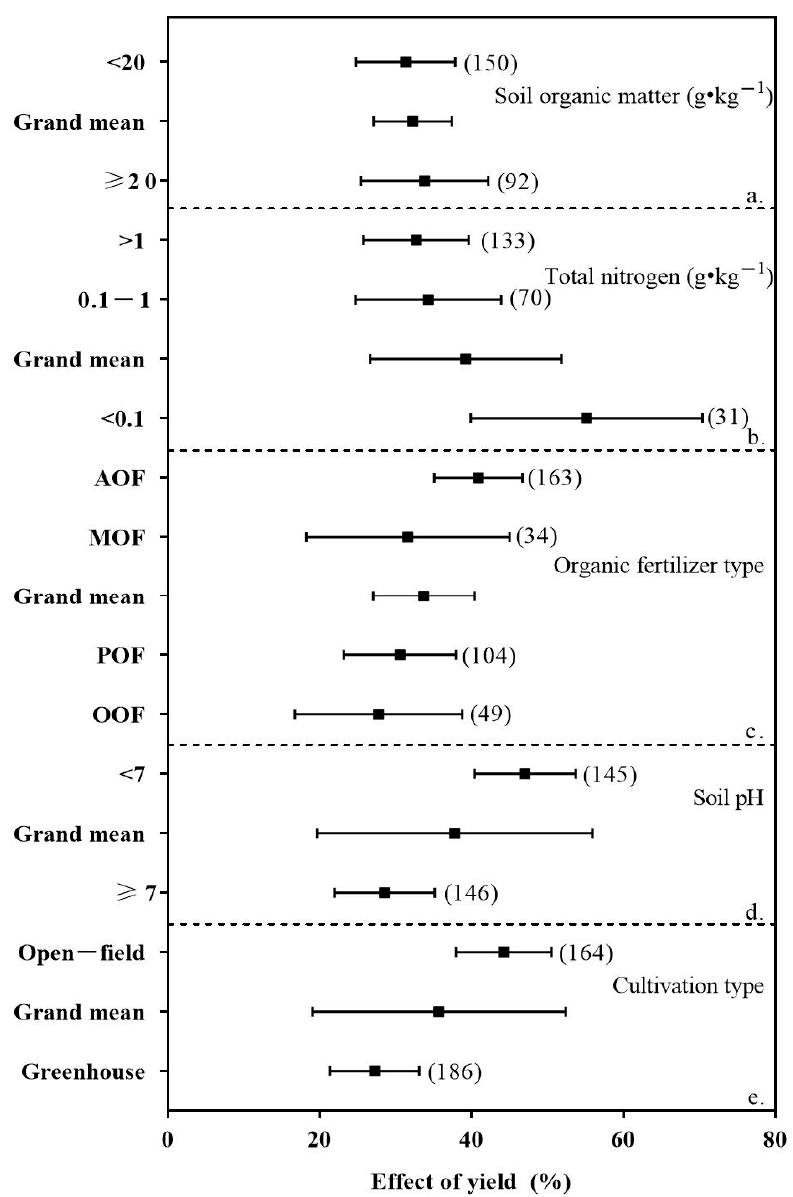
Figure 4. Organic fertilizers combined with soil organic matter ( a ), total soil nitrogen ( b ), type of organic fertilizers ( c ), soil pH ( d ), and cultivation type ( e ) on tomato yield percentage changes. Points represent the mean effect, while bars represent 95% confidence intervals. The numbers on the right side of the confidence intervals represent the sample sizes. AOF, animal organic fertilizer; MOF, mixed animal-and-plant organic fertilizer; POF, plant organic fertilizer; OOF, other organic fertilizer. The percentage change of organic fertilizers on the soluble sugar of tomato increased significantly when the organic matter was <20 g · kg − 1 ; the percentage change of organic fertilizers on the soluble sugar of tomato increased by 60.35% (Figure 6a). The percentage change was − 18.09% when the organic fertilizers were ≥ 20 g · kg − 1 . When the total soil nitrogen was 0.1–1 g · kg − 1 and >1 g · kg − 1 , organic fertilizers had positive effects on tomato soluble sugar, and the percentage changes were 51.86% and 30.53%, respectively (Figure 6b). Both plant organic fertilizers and animal organic fertilizers had positive effects on tomato soluble sugar, and the respective percentage changes were 48.04% and 48.02%; thus,